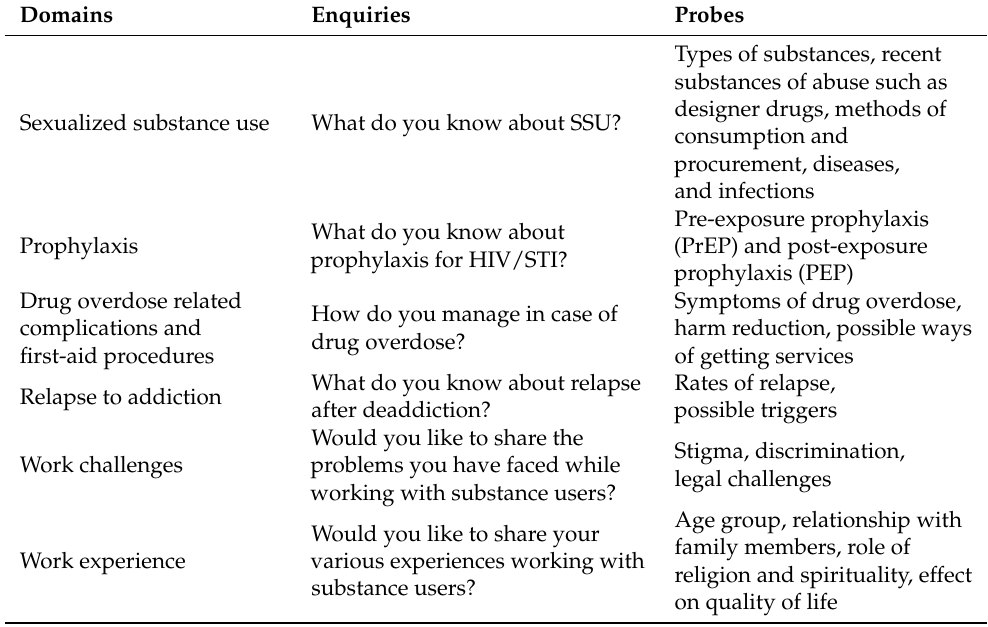
Table 1. Qualitative interview